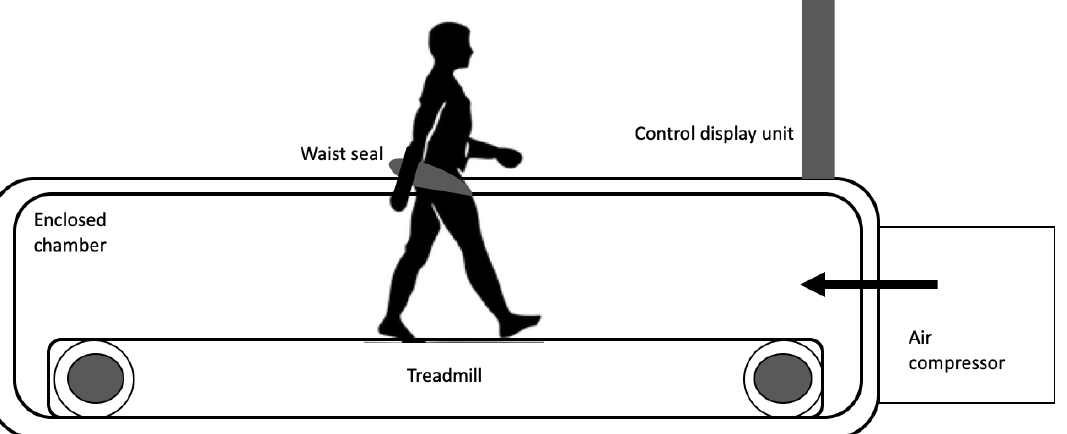
Figure 2. Figure illustrating the setup of lower-body positive pressure (LBPP) or antigravity treadmill.